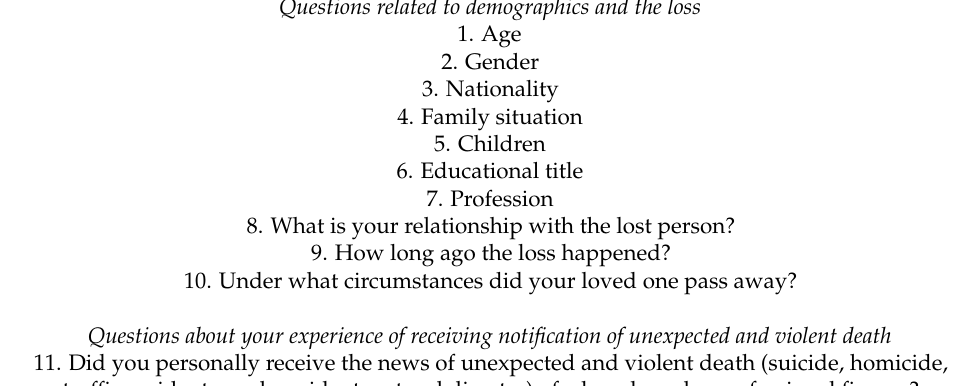
Table 1. The ad hoc